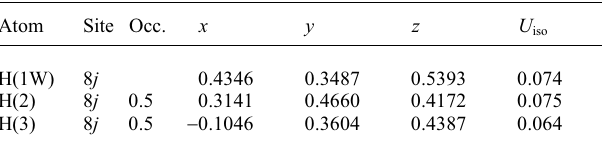
Table 2. Atomic coordinates and displacement parameters (in Å 2 ) . Table 2. continued